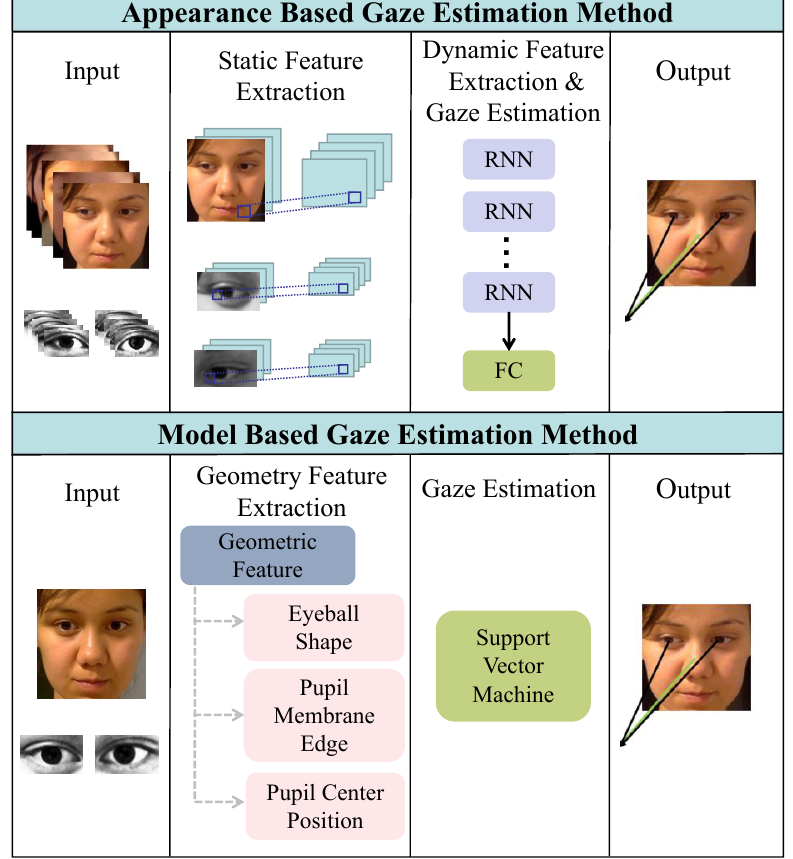
Figure 1. Two categories of gaze estimation methods: (1) appearance-based gaze estimation method; (2) model-based gaze estimation